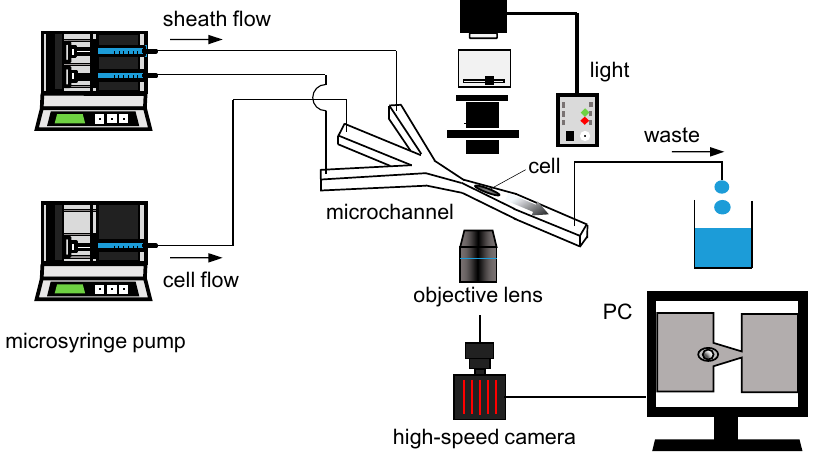
Figure 2. Schematic illustration of the experimental setup. The microflow channel was placed under the microscope and cell deformation was recorded with a high-speed camera.